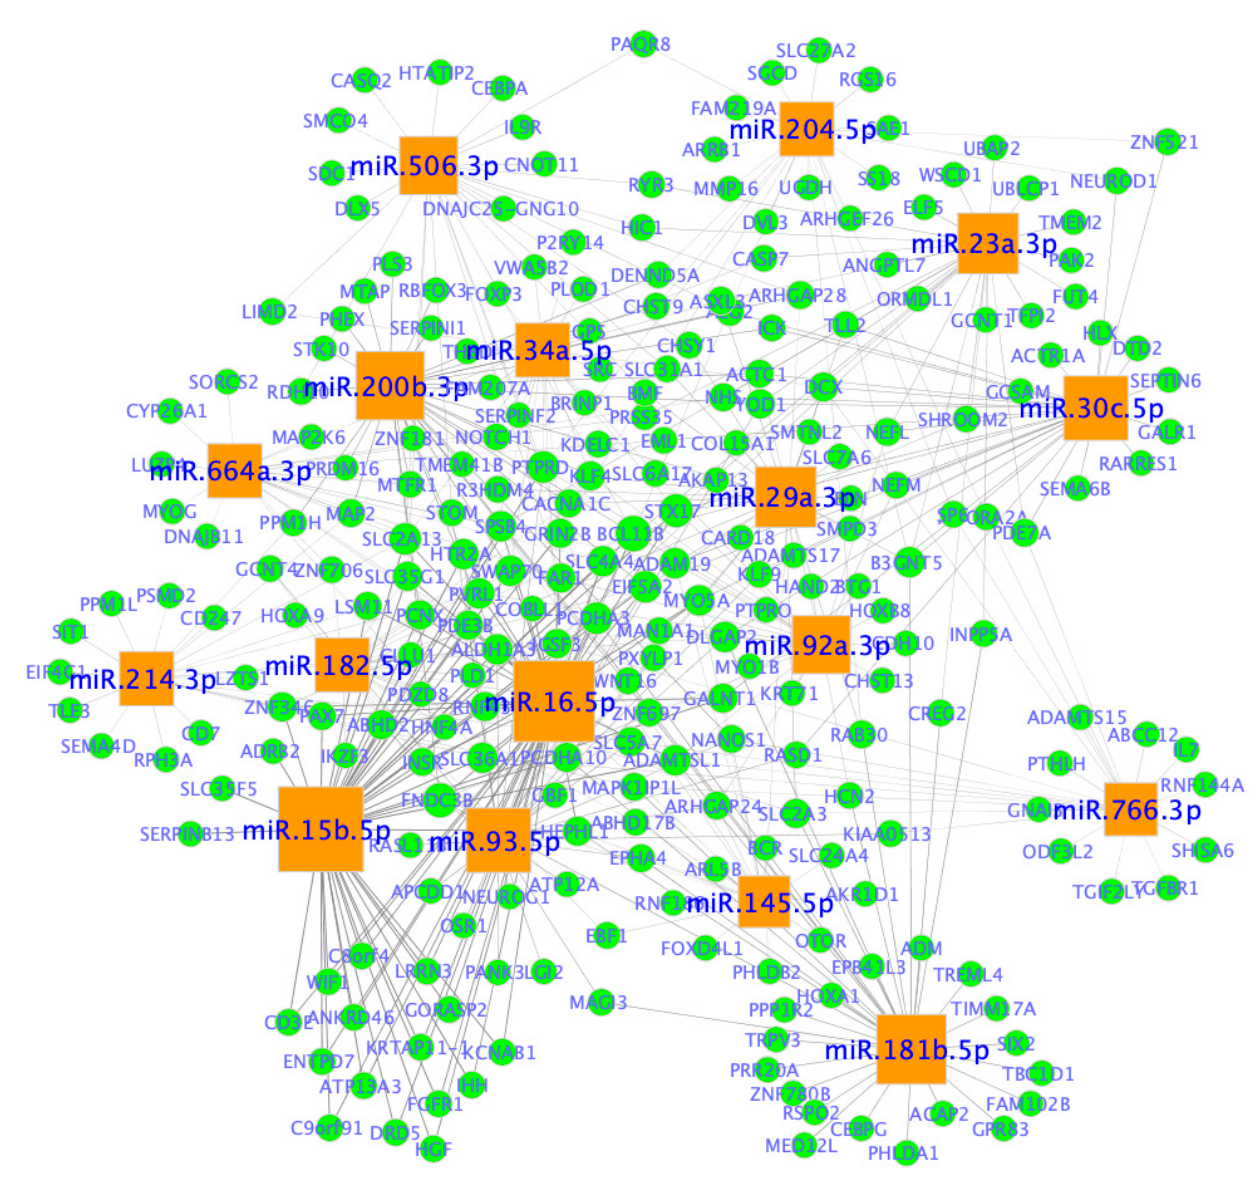
Figure 11. miRNA-mRNA networks in ovarian cancer. Network nodes represent miRNAs and genes (mRNAs), whereas edges represent an association between a miRNA and a gene. miRNAs are represented by orange squares and genes are shown in blue circles. miRNA node size is proportional to the number of genes it is predicted to interact with. Network was created in Cytoscape (https://cytoscape.org/ (accessed on 20 January 2023).